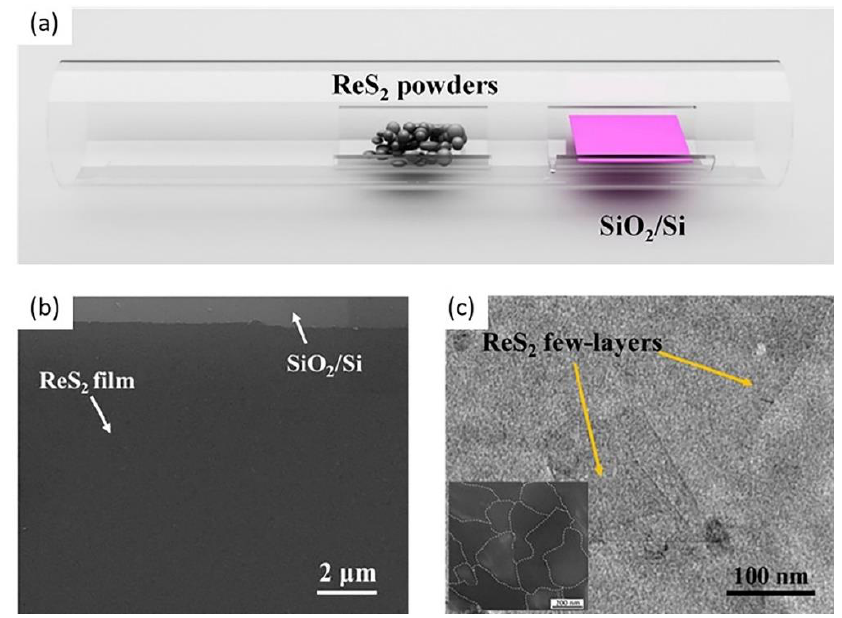
Figure 8. ( a ) Schematic diagram of synthesized ReS 2 film by PVD. ( b ) SEM image of ReS 2 film. ( c ) TEM image of the ReS 2 film. Reprinted with permission from ref. [ 96 ] . Copyright 2016 Elsevier.